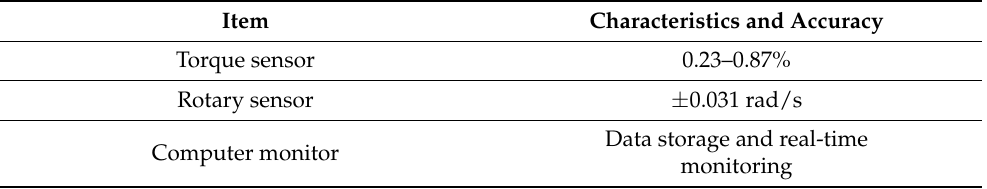
Table 1. Specifications and accuracies of measurements.